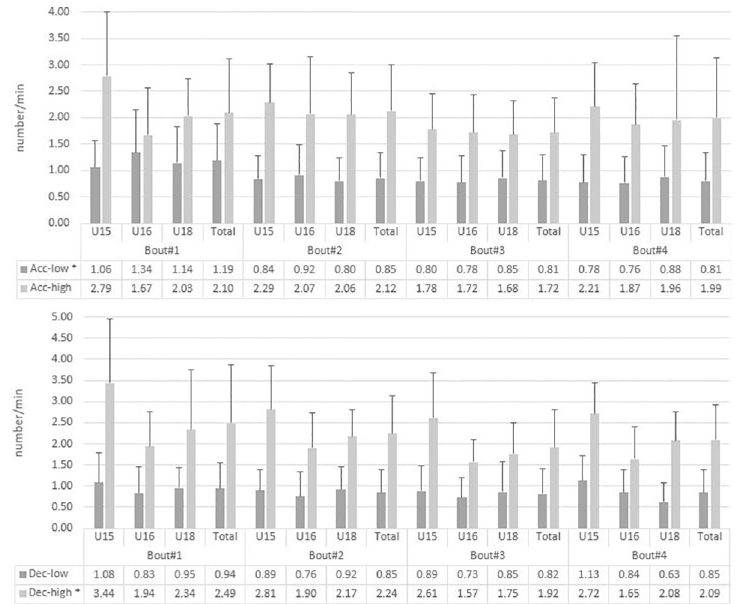
Fig 2. Number of low ( < ± 3 m � s -2 ) and high ( � 3 ± m � s -2 ) acceleration and deceleration over the course of training concerning age groups. Panel A presents number of acceleration-low & high as mean-values in number/min. Panel B shows the number of deceleration-low & high as mean-values in number/min. � Significant differences (P �